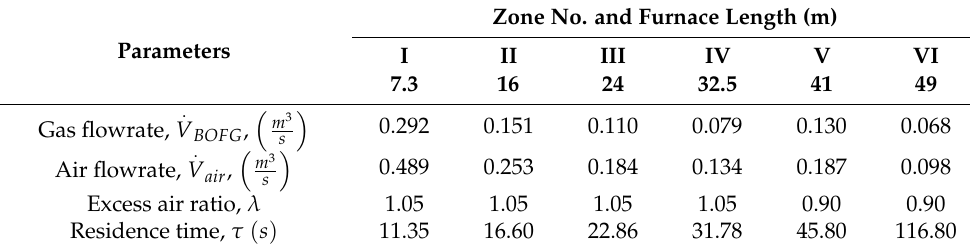
Parameters Table 2. Parameters of the BOFG powered furnace adopted for calculations. Parameters